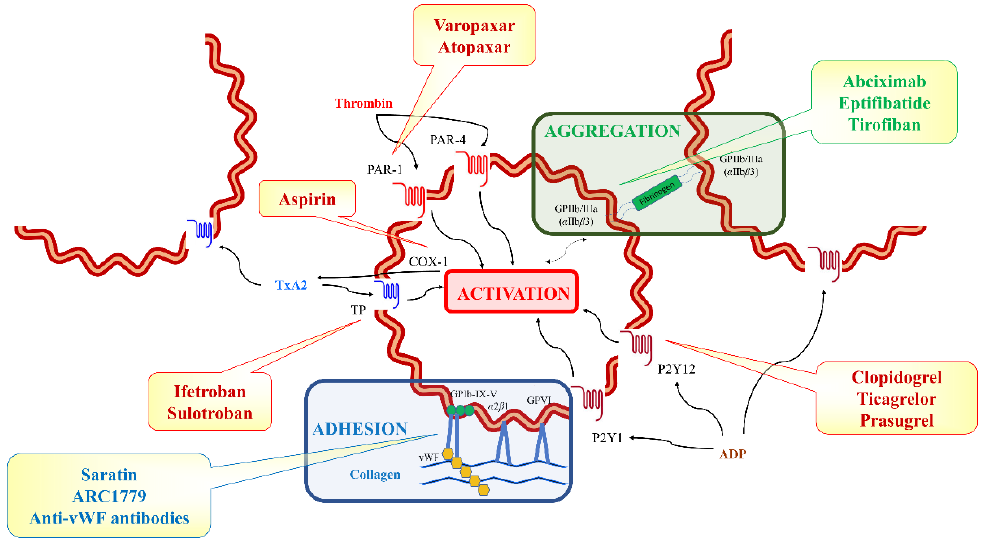
Figure 3. Main receptors and ligands involved in platelets’ adhesion, activation, and aggregation. The boxes indicate some examples of existing or emerging antiplatelet therapies.